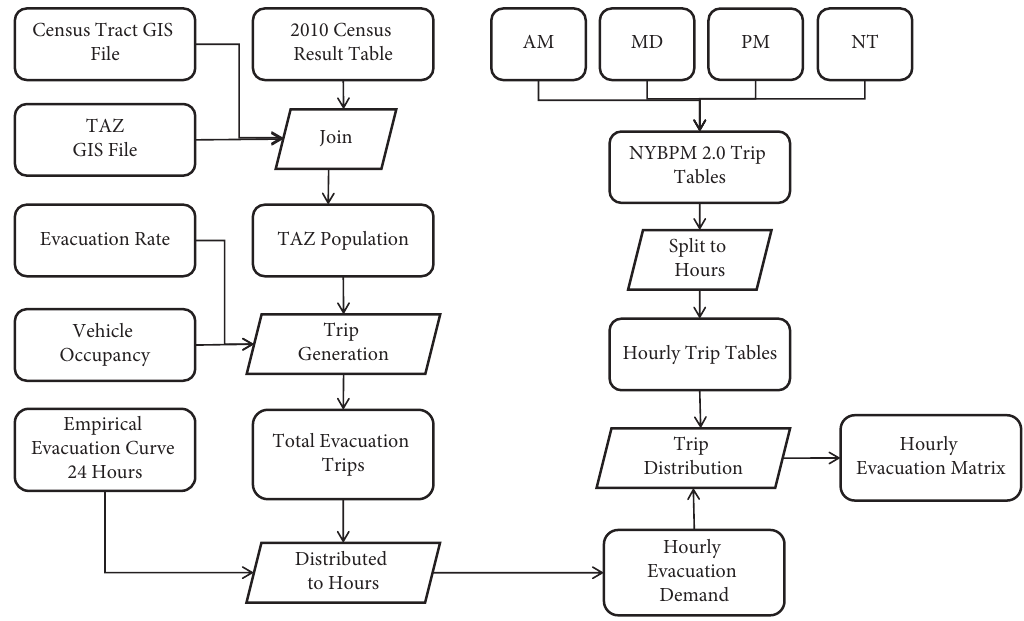
Figure 3: Procedure of demand modeling. Table 3: Result statistics for the incident frequency model.